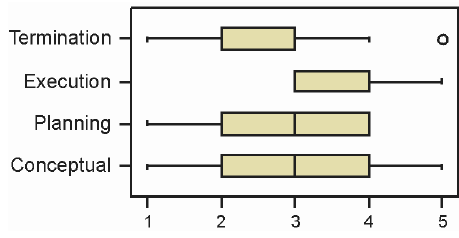
Fig. 3. Computer usage in PPP projects